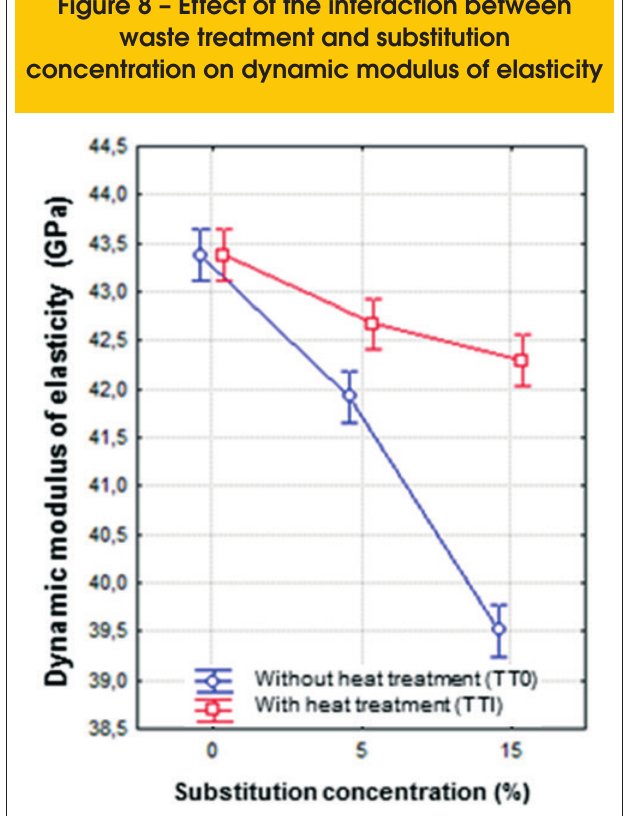
Figure 8 – Effect of the interaction between waste treatment and substitution concentration on dynamic modulus of